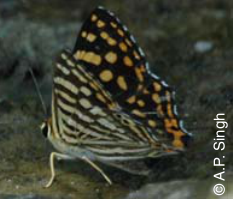
Image 30. Tailed Punch, Dodona eugenes